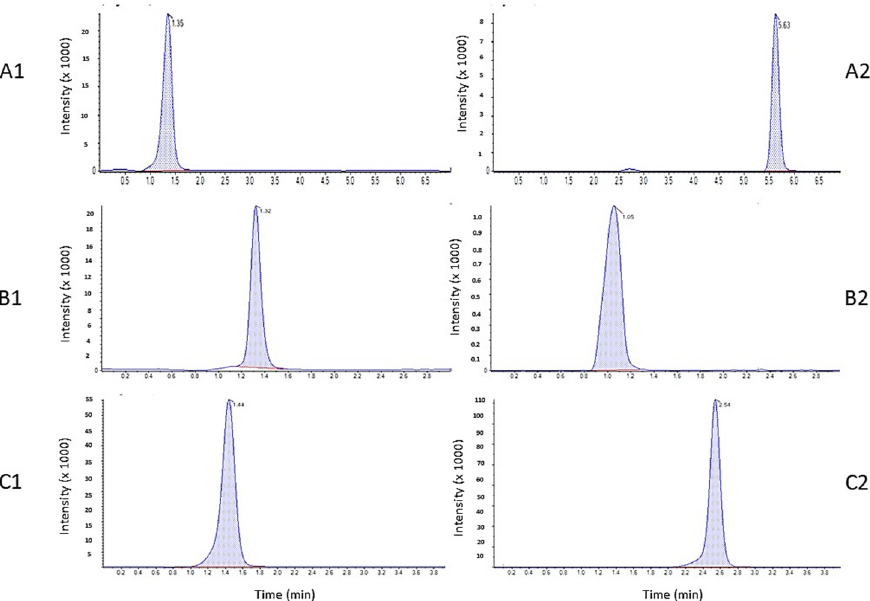
Figure 2. Representative mass chromatograms of blank human plasma spiked with 250 ng / mL IS ( A1 , B1 , and C1 ) and 100 ng / mL AW-9a ( A2 ), 250 ng / mL WES-1 ( B2 ), and 120 ng / mL WES-2 ( C2 ).